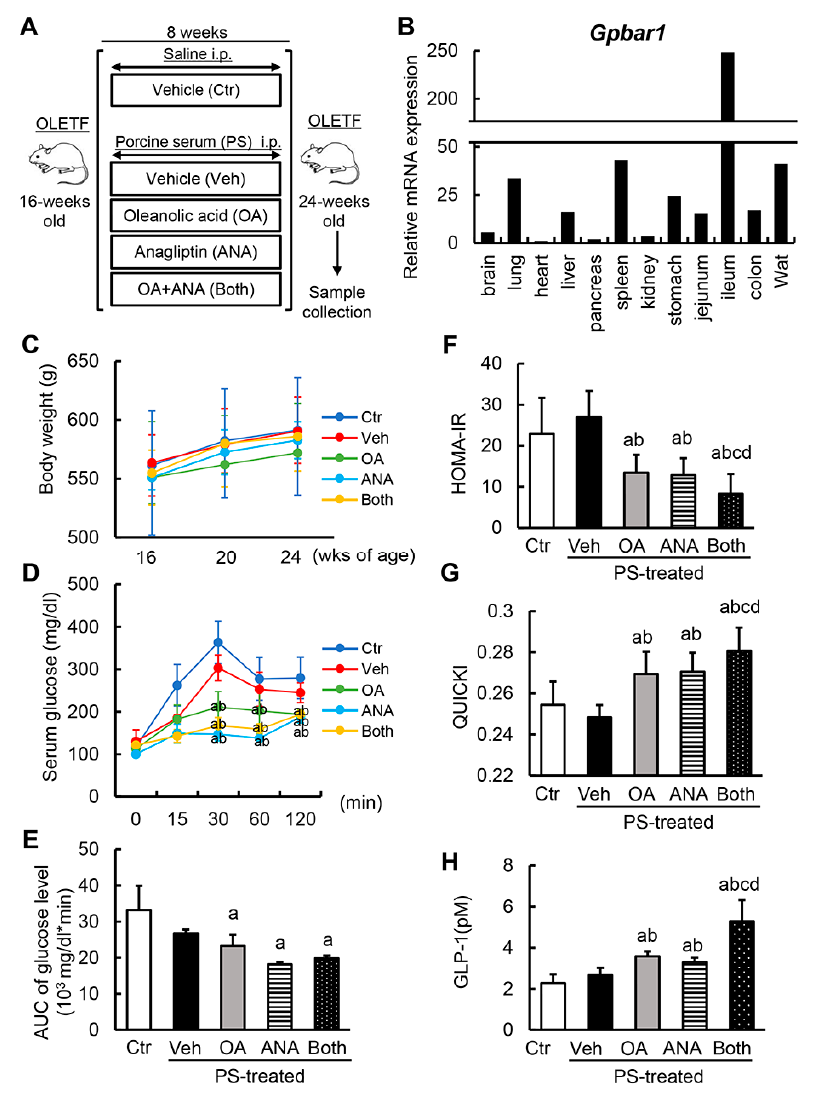
Figure 2. In vivo e ff ects of oleanolic acid and anagliptin on glycemic status. ( A ) Schematic of porcine-serum (PS)-induced rat liver fibrosis models. ( B ) Histological distribution of Gpbar1 mRNA expression in OLETF rats. Quantitative values are relatively indicated as ratios to the values of rat heart tissue. ( C ) Changes in body weights during experimental period. ( D ) Serum glucose levels in oral glucose tolerance test (OGTT) at the end of experiment. ( E ) The values of glucose–AUC (area under the blood concentration–time curve) in the experimental groups. The values of AUC were calculated as area under the curve of serum glucose levels at OGTT. ( F , G ) The values of homeostasis model assessment–insulin resistance (HOMA–IR) ( F ) and Quantitative Insulin Sensitivity Check Index (QUICKI) ( G ) in experimental rats. ( H ) The serum levels of rat GLP-1 at the end of experiment. Relative mRNA expression levels were measured by quantitative RT-PCR (qRT-PCR). Gapdh was used as internal control for qRT-PCR ( B ). Data are mean ± SD ( B – G ; n = 10, H ; n = 8). Ctr; negative control group, Veh; vehicle-treated PS-injected group, OA; oleanolic acid-treated PS-injected group, ANA; anagliptin-treated PS-injected group, Both; oleanolic acid and anagliptin-treated PS-injected group. a , P ≤ 0.05 compared with Ctr-group; b , P ≤ 0.05 compared with Veh-group; c , P ≤ 0.05 compared with OA-group; d , P ≤ 0.05 compared with ANA-group.